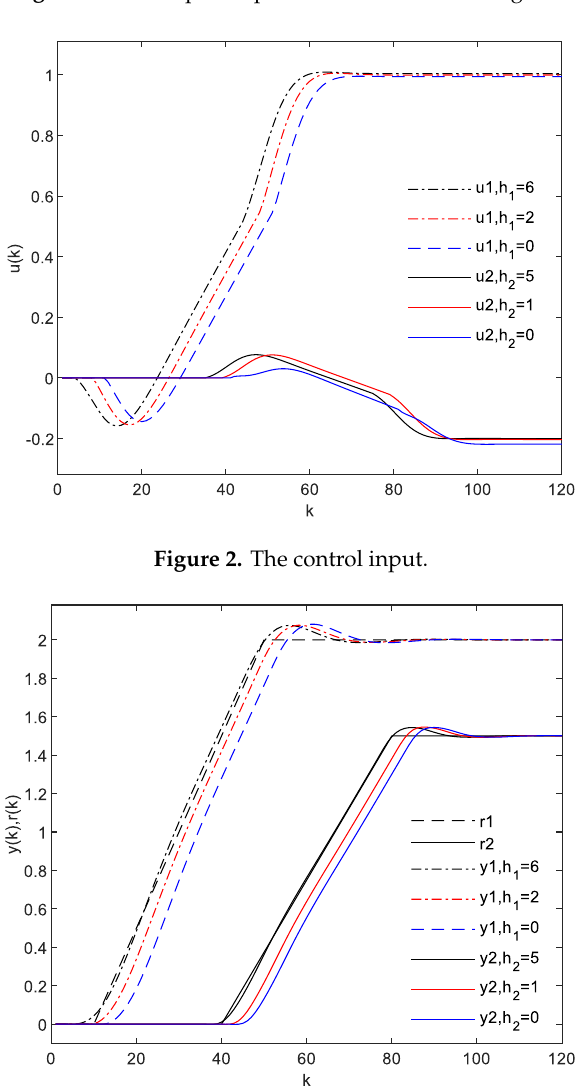
Figure 3. The output response of System (1) with θ 1 =